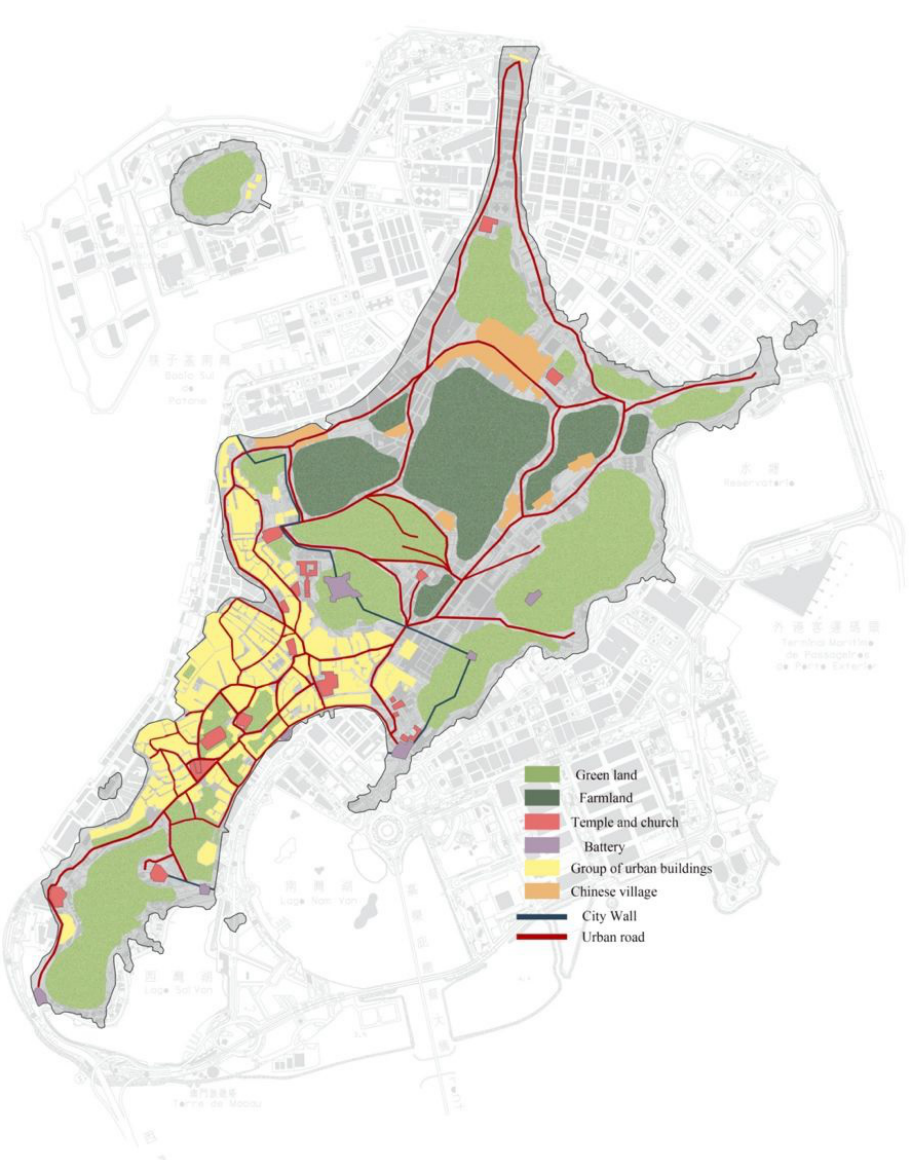
Fig. 3 Main buildings and streets of Macau in the 17th